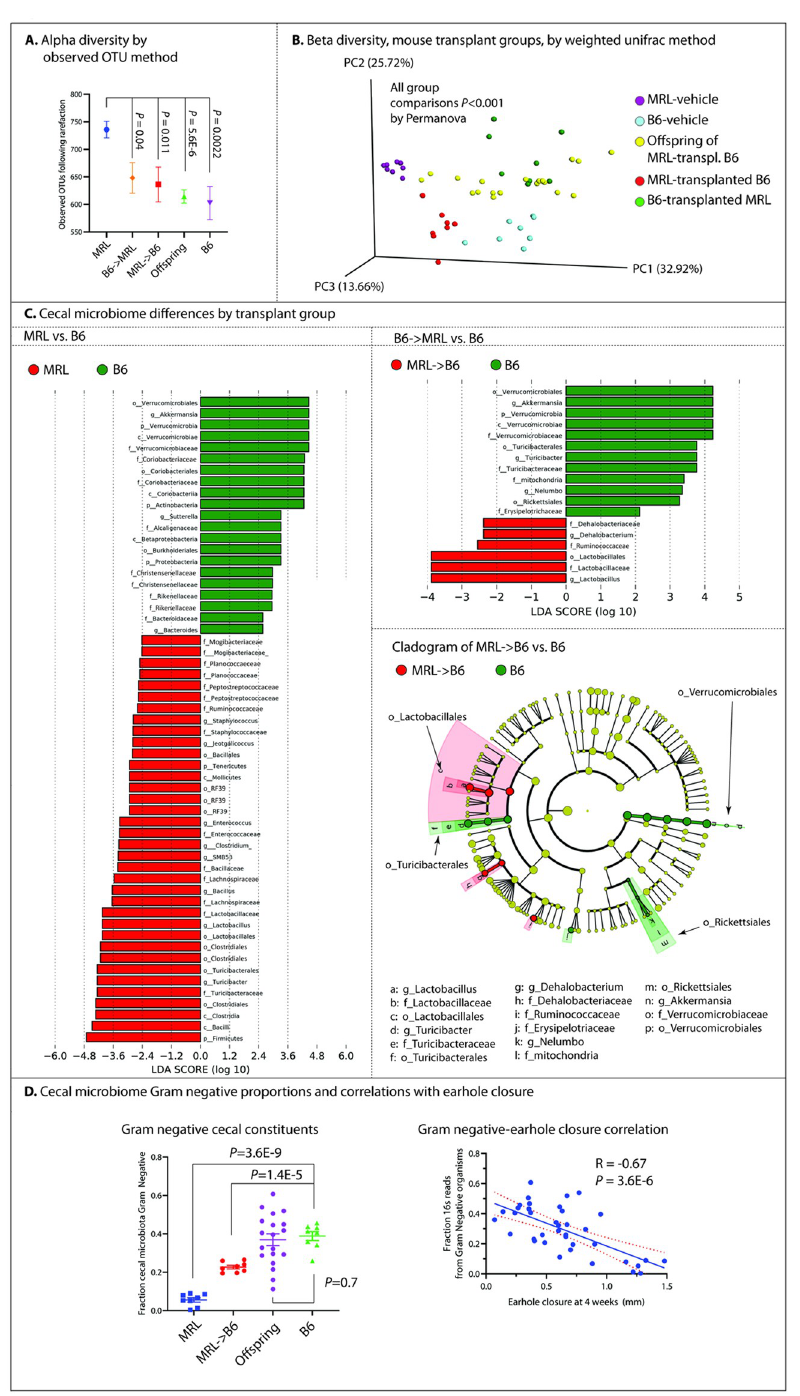
Fig 3. 16S cecal microbiome